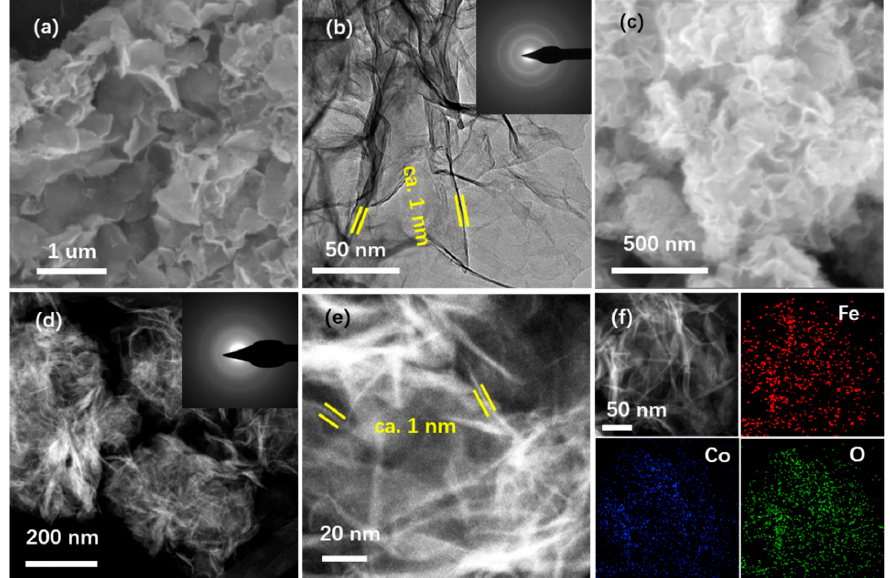
Figure 1. Electrochemical characterization of MCoO x ANSs. Polarization curves ( a ), specific Tafel slopes ( b ), specific overpotential of achieving 10 mA/cm 2 ( c ), and specific mass activity at 1.5 V vs. RHE ( d ) of Co-based ANSs. Fe 1 Co 1 O x ANSs show highest OER activity among these Co-based ANSs.